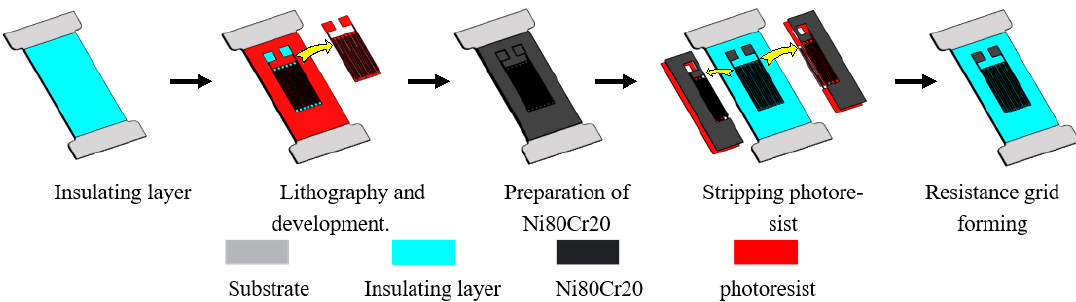
Figure 1. The film pattering process of PMS.